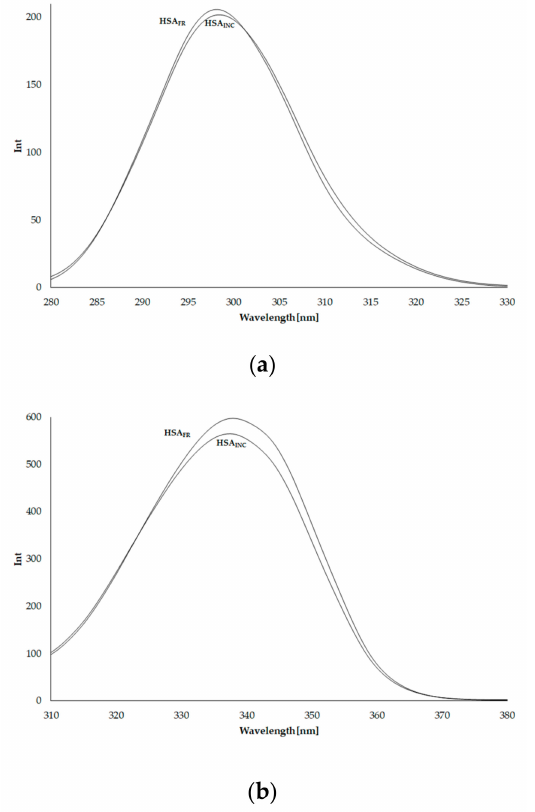
Figure 4. Synchronous fluorescence spectra of HSA FR and HSA INC at 5 × 10 − 6 mol · L − 1 concentration; ( a ) ∆ λ 15 nm, ( b ) ∆ λ 60 nm.